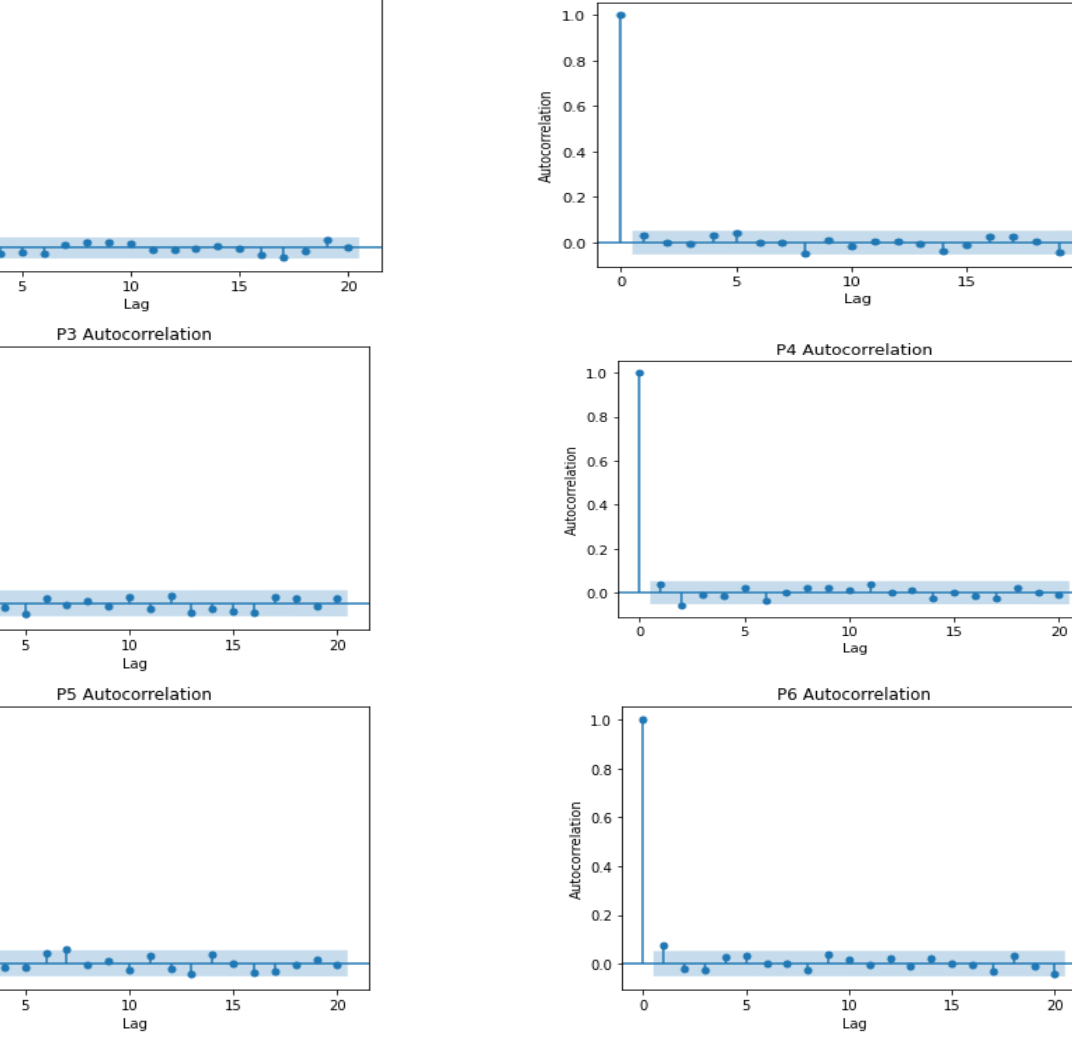
Figure 18. Autocorrelation results.